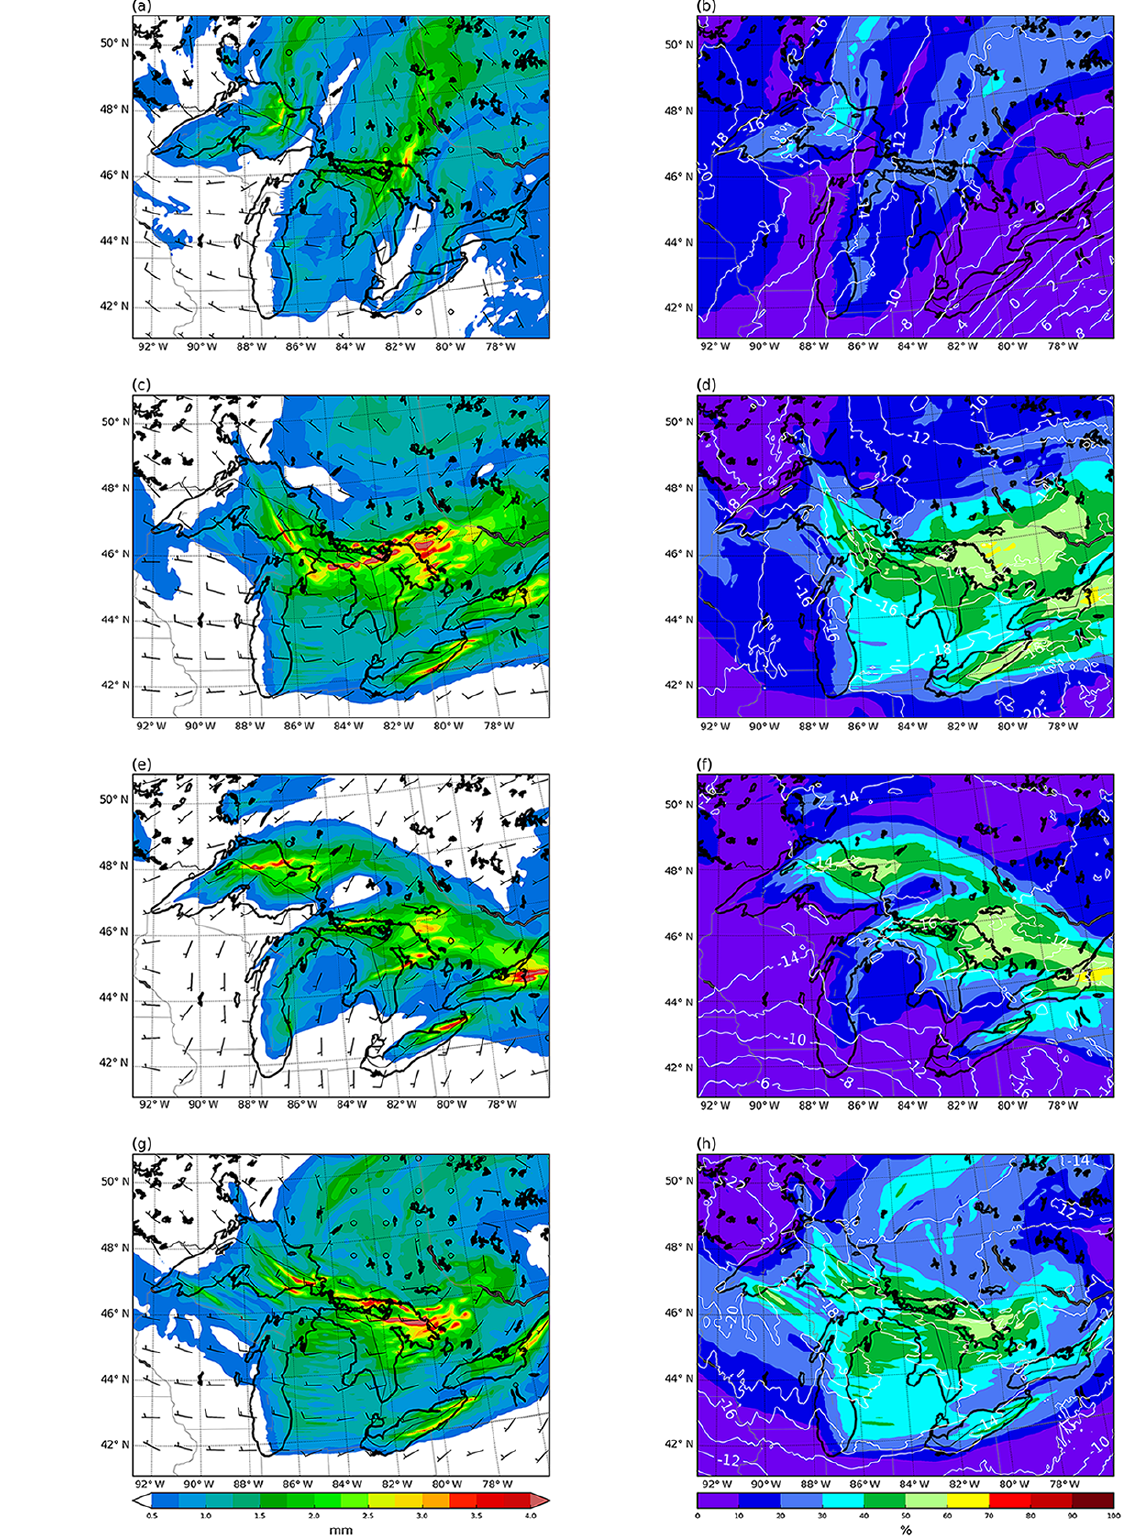
Figure 11. Total precipitable water (mm) originating from lake evaporation on 17 (a) , 18 (c) , 19 (e) and 20 (g) November 2014 at 12:00UTC and their percentage contribution to total precipitable water for the same times (b, d, f, h) . Wind barbs show 10m winds and contours 850hPa temperature ( ◦